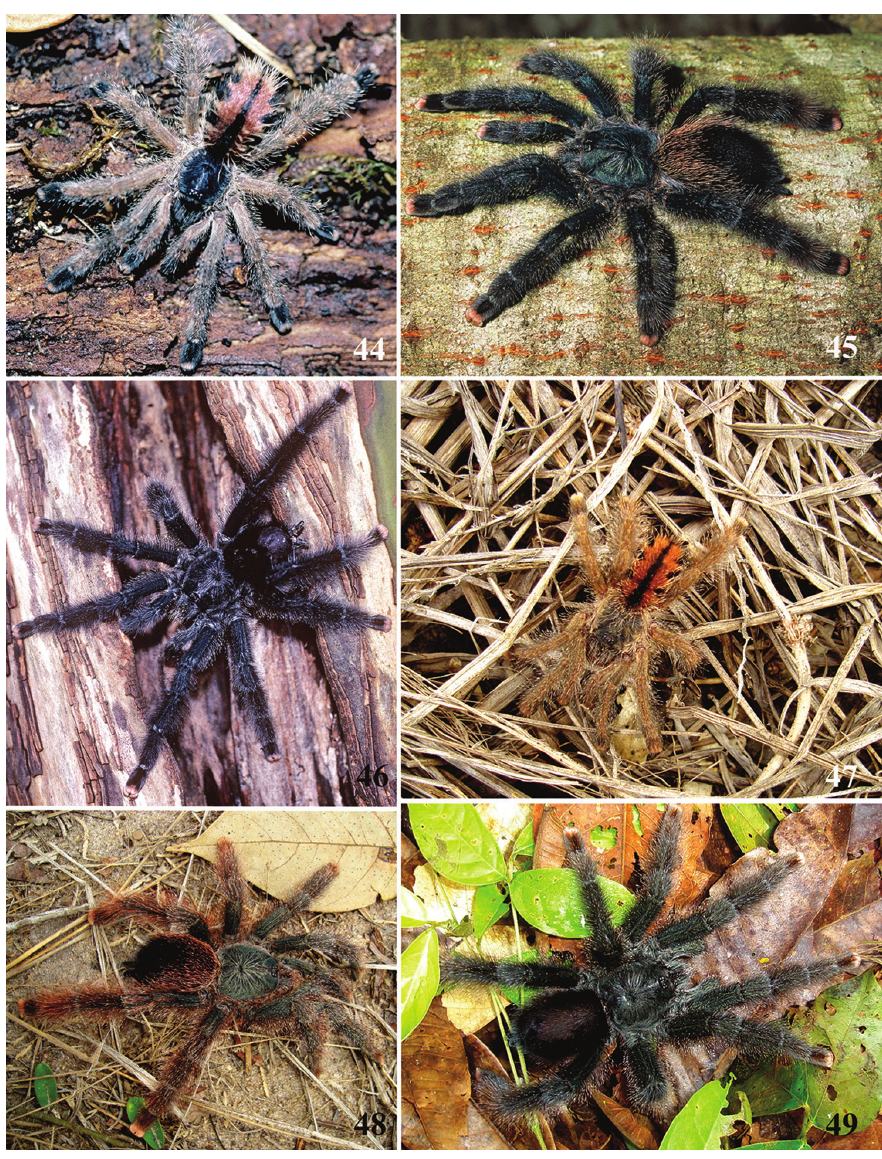
Color pattern ontogeny. Brownish juveniles lacking metallic sheen, black tarsi contrasting with other lighter articles and abdomen dorsum reddish, with dorsal cen- tral longitudinal black stripe disconnected from transversal black stripes (Figs 37, 44, 47). When mature, both males and females lose this